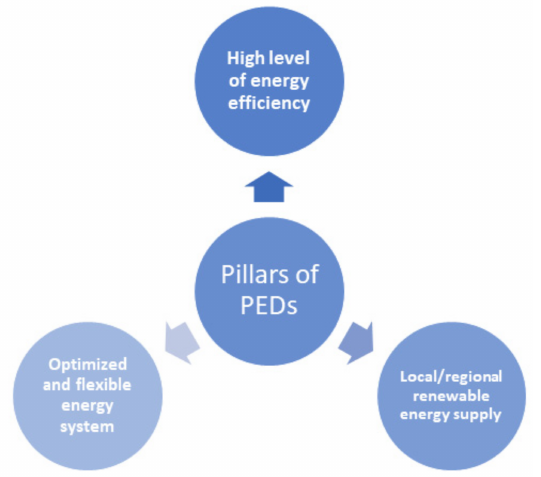
Figure 1. Functions and pillars of Positive Energy Districts (PEDs) within the urban energy system (Source: